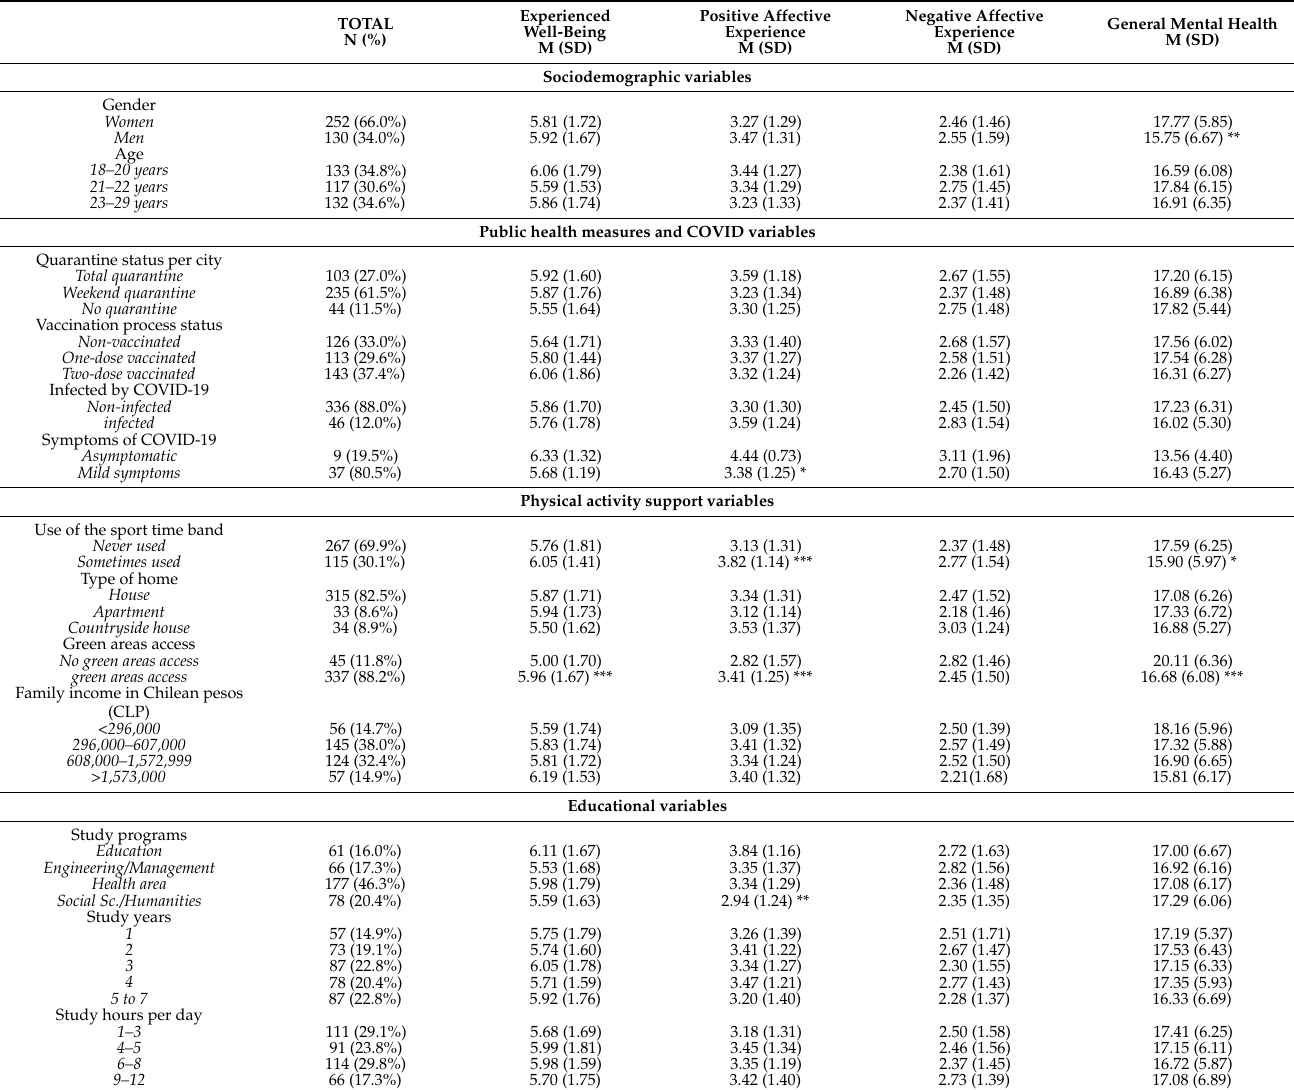
Table 1. Descriptive data of the participants’